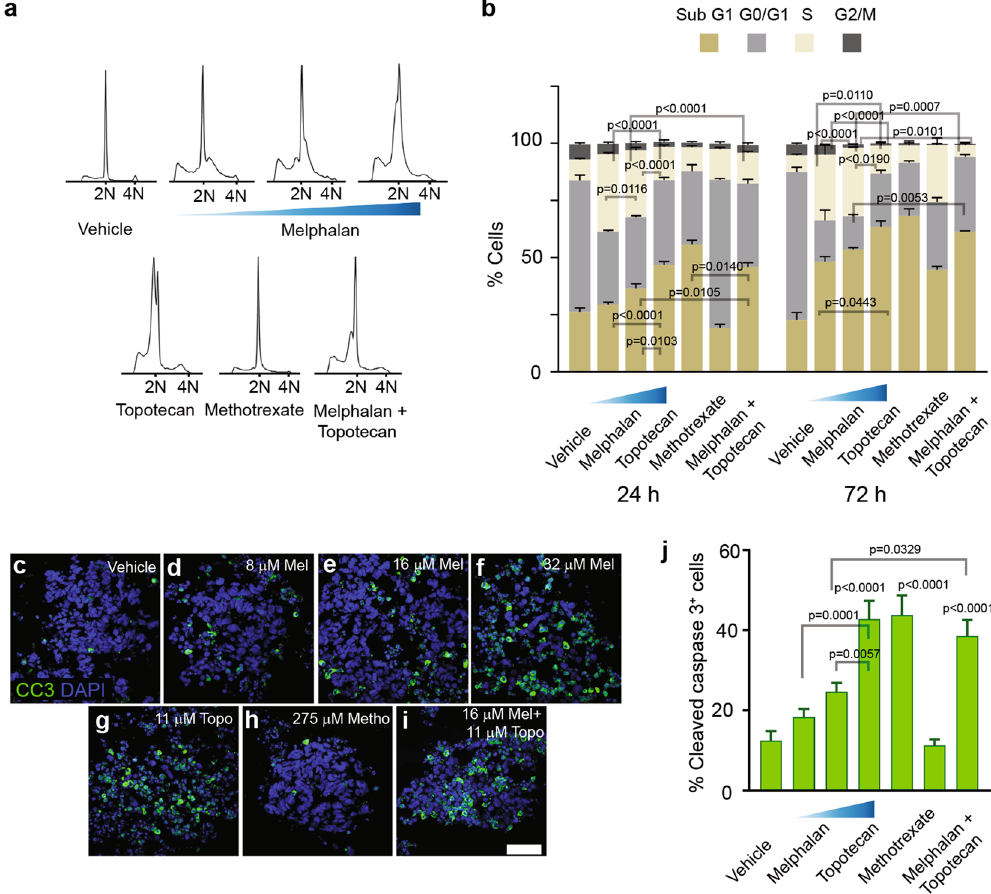
Figure 5. Chemotherapeutic drug responses of tumor organoids. ( a , b ) Cell cycle analysis of RB688 organoids in response to anticancer drugs at 24 ( a , b ) and 72 ( b ) h after drug administration. Statistical analysis of cell cycle phases at each time point (mean percentage ± SEM, n = 3) was conducted by one-way ANOVA followed by Tukey’s test. ( c–i ) Representative micrographs of immunostaining for cleaved caspase 3 (CC3), an indicative marker of apoptotic cells, in organoids treated with vehicle ( c ), 8 ( d ), 16 ( e ), or 32 ( f ) µ M melphalan (Mel), 11 µ M topotecan (Topo) ( g ), 275 µ M methotrexate (Metho) ( h ), or the combined regimen of 16 µ M melphalan with 11 µ M topotecan ( i ). Nuclei stained by 4 ′ ,6-diamidino-2-phenylindole (DAPI). Scale bar, 50 µ m. ( j ) Bar graph indicates % CC3 + cells (mean percentage ± SEM, n = 3) after exposure to drugs for 24 h. Mean percentages were determined from 7–10 micrographs containing 300–500 cells for each condition. Statistical analysis of % CC3 + cells was conducted by one-way ANOVA followed by Tukey’s test. The p values of single or combined agents vs. vehicle for cell cycle analysis are listed in the